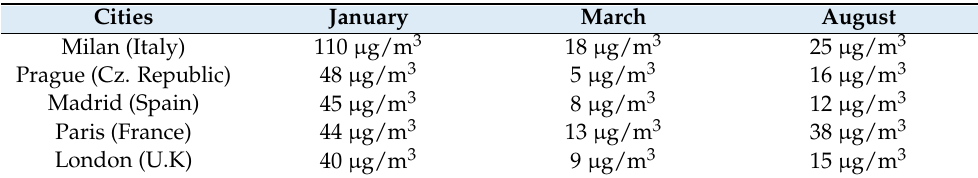
Table 2. Values of PM 10 over different cities during different periods of time. Source: Own elabora- tion. Cities January March